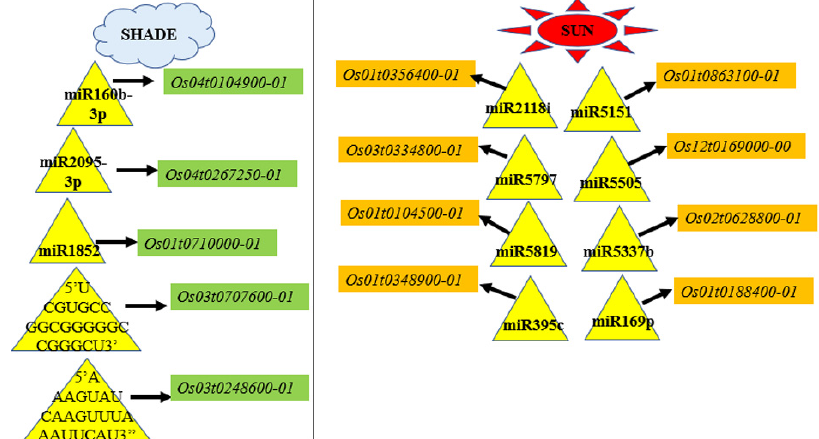
Figure 8. Pictorial representation of transcript regulation by uniquely expressed miRNAs. Repre- sented miRNAs are uniquely expressed under either the sun or shade. However, their expression levels were associated with differential expressions of their targets due to cleavage, as identified by degradome sequencing. Transcript expressions were verified with microarray expression analysis. Yellow color: upregulated transcripts; green color: downregulated transcripts. The black arrow indicate cleavage. Diagram is not to scale.